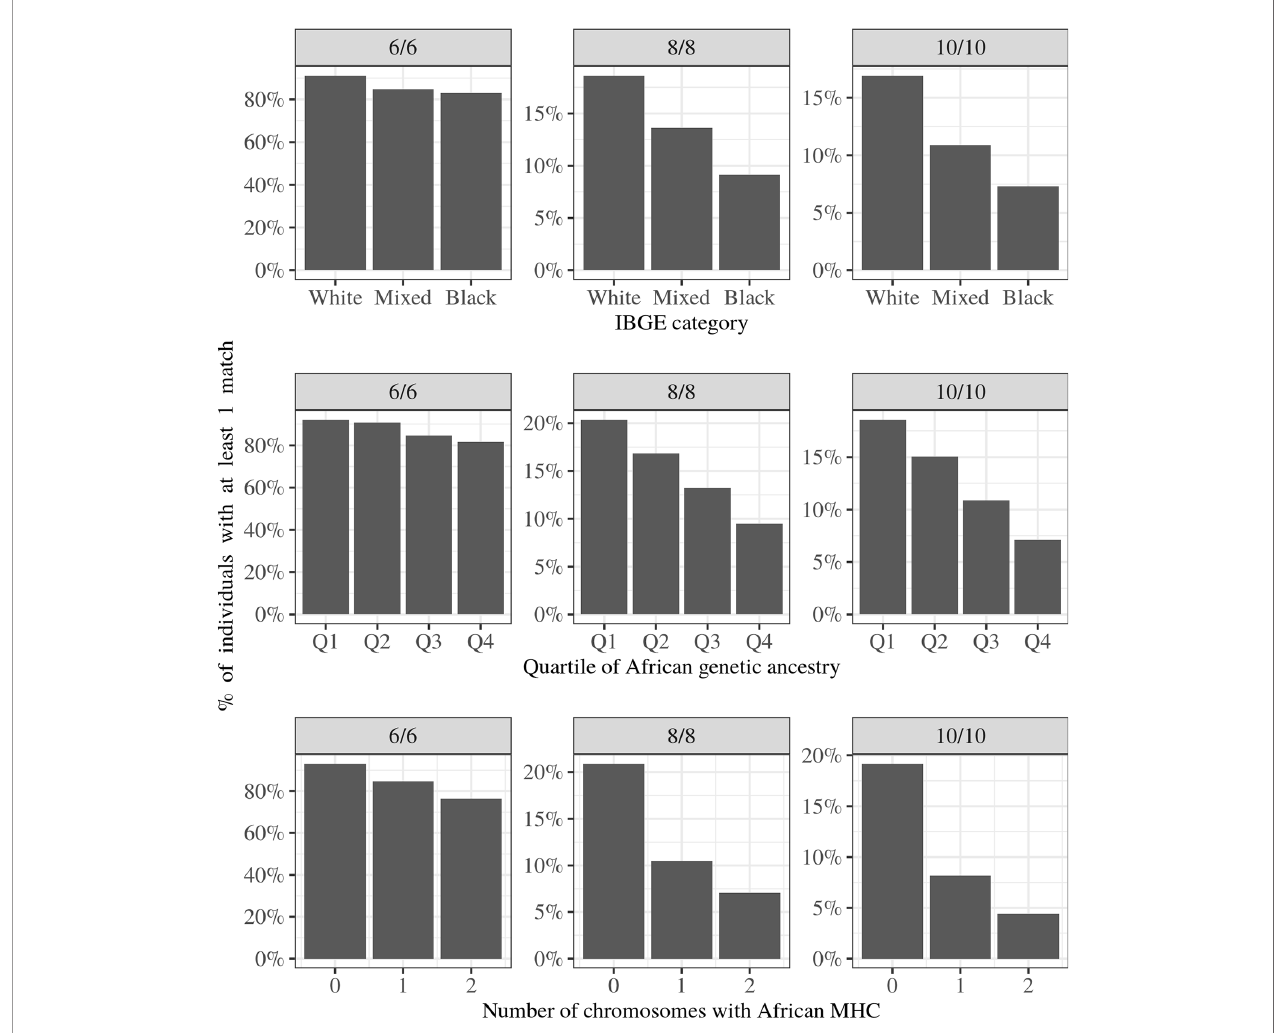
FIGURE 3 | Percentage of individuals from the merged dataset with at least one match in Brazilian Bone Marrow Donor Registry (REDOME) for low resolution 6/6, 8/8, and 10/10. Top row: Brazilian Institute of Geography and Statistics (IBGE) categories; Middle row: Quartile of African ancestry; Bottom row: Number of chromosomes with African MHC per